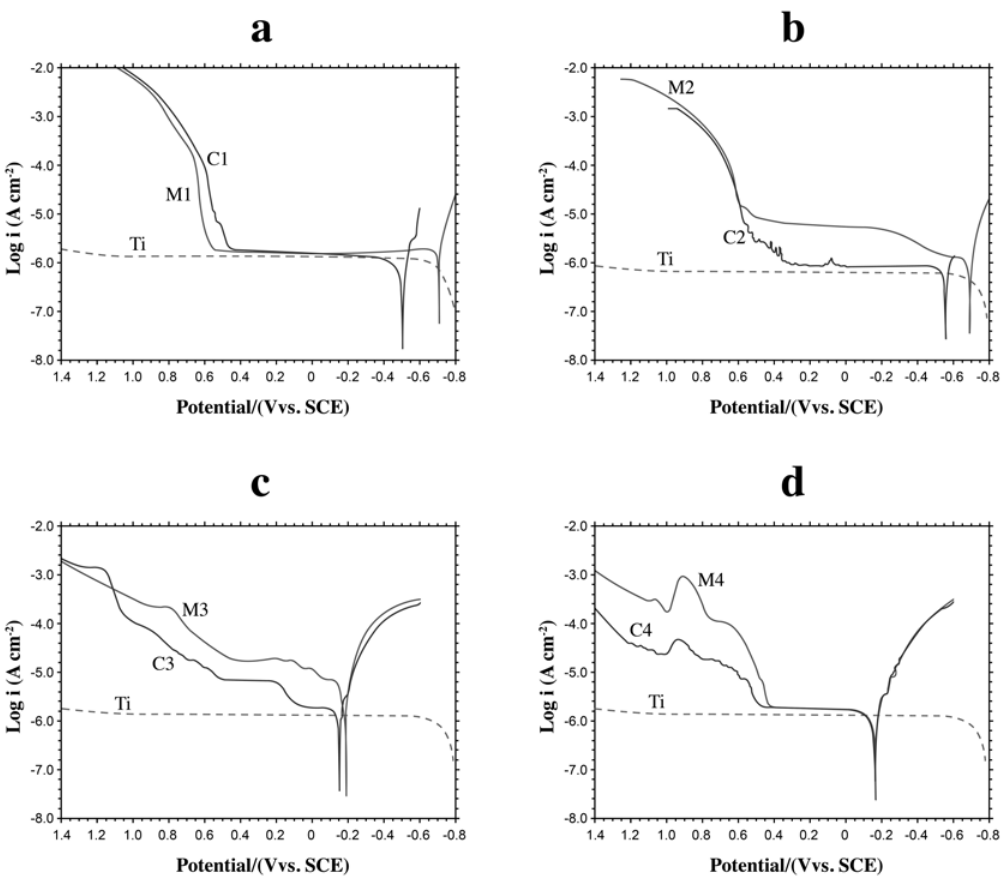
FIGURE 3- Potentiodynamic polarization curves at 37 °C in Afnor type solution (scan rate: 1 mV sec -1 ). (a) M1, C1 and Ti (b) M2, C2 and Ti (c) M3, C3 and Ti (d) M4, C4 and Ti